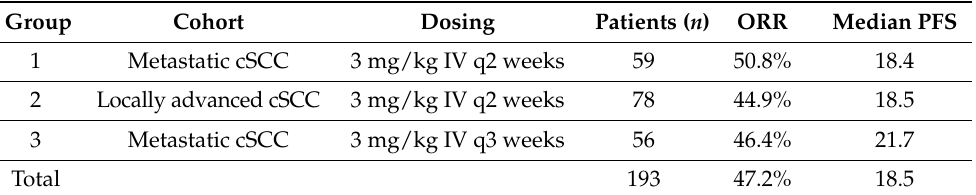
Table 4. Expanded follow-up of phase 2 cemiplimab data; ORR, objective response rate; PFS, progression free survival (in months).